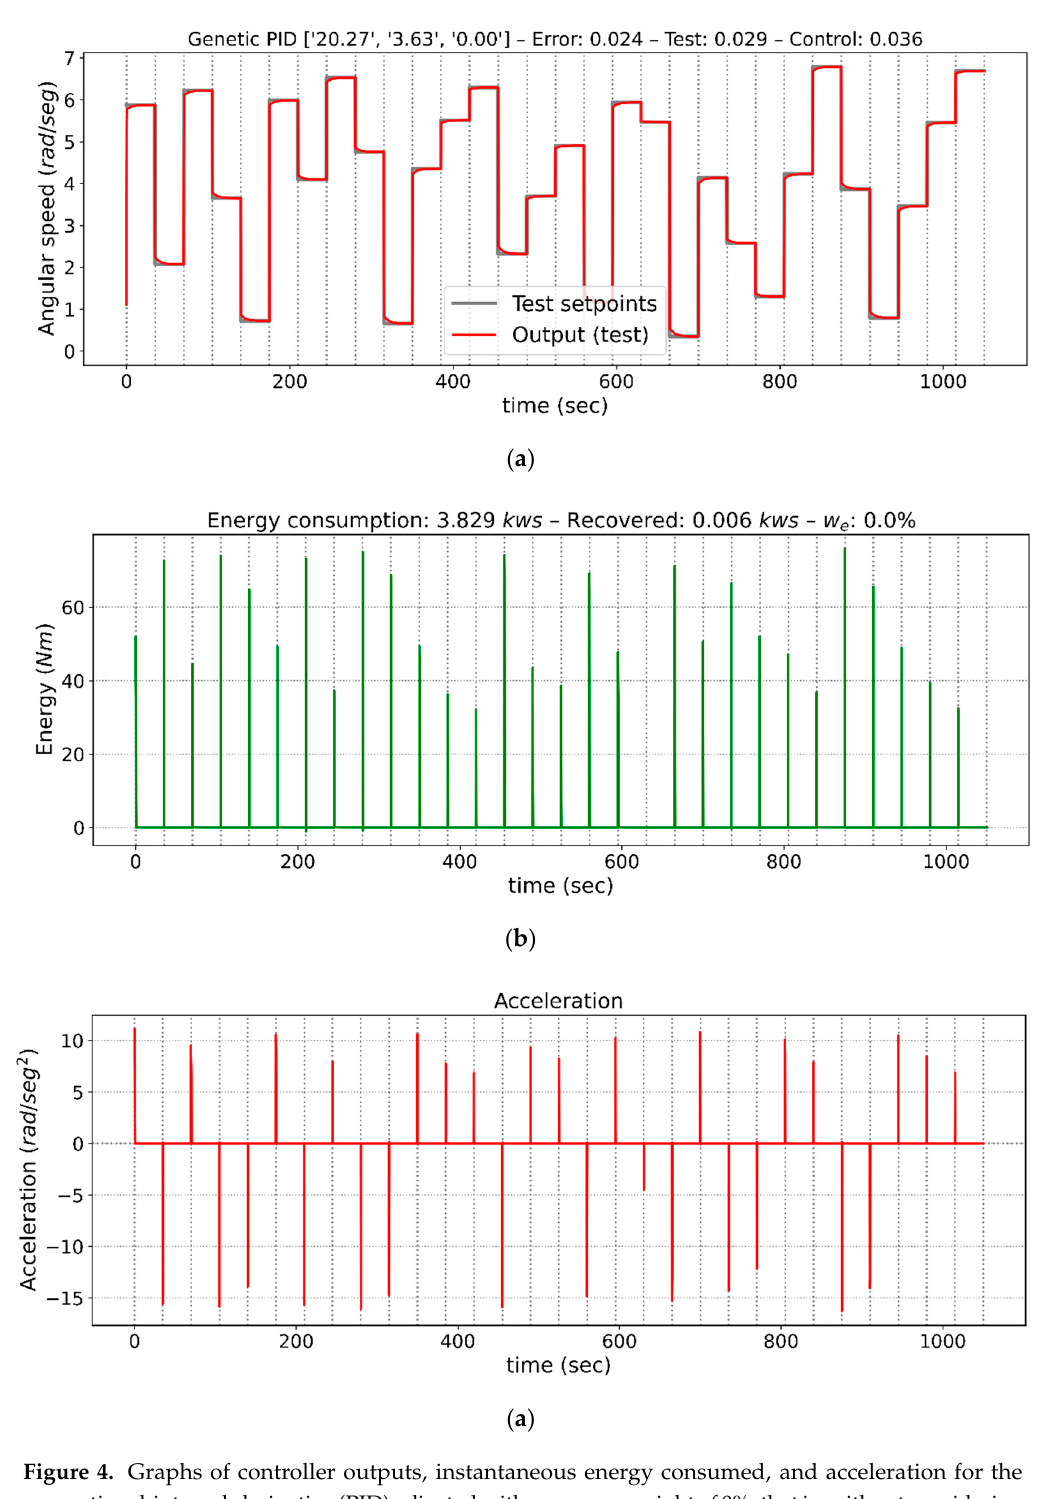
Figure 4. Graphs of controller outputs, instantaneous energy consumed, and acceleration for the proportional-integral-derivative (PID) adjusted with an energy weight of 0%, that is, without considering consumption. ( a ) Speed response of the drive, ( b ) Energy consumption, ( c ) Acceleration of the drive.